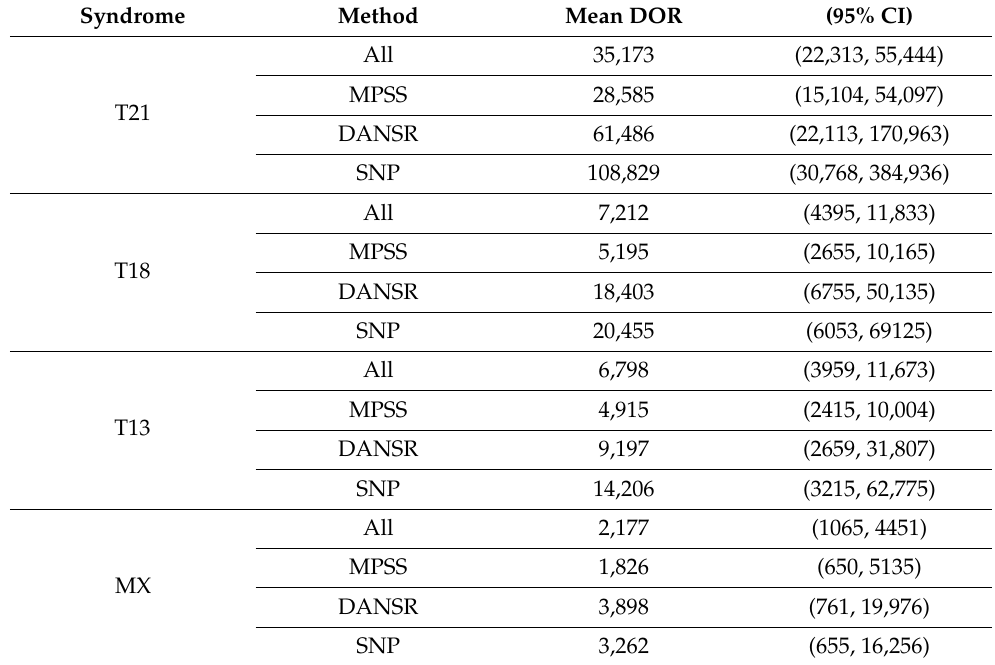
Table 3. Validation studies: summary estimates for Diagnostic Odds Ratio (DOR) from univariate model, by syndrome and